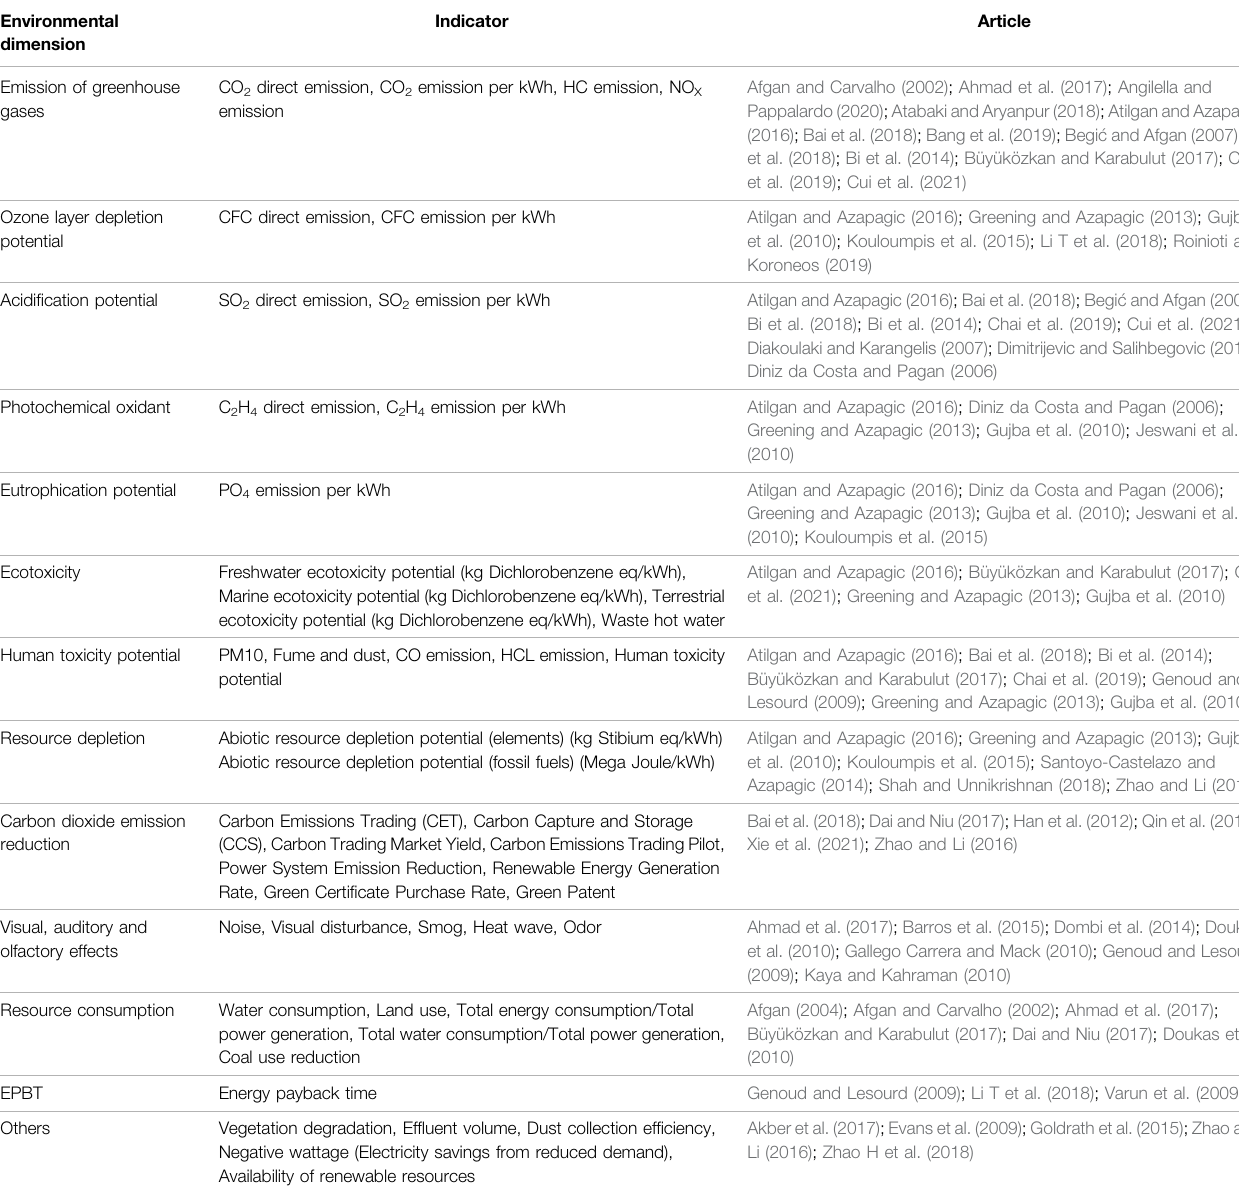
TABLE 7 | Summary of environmental sustainability